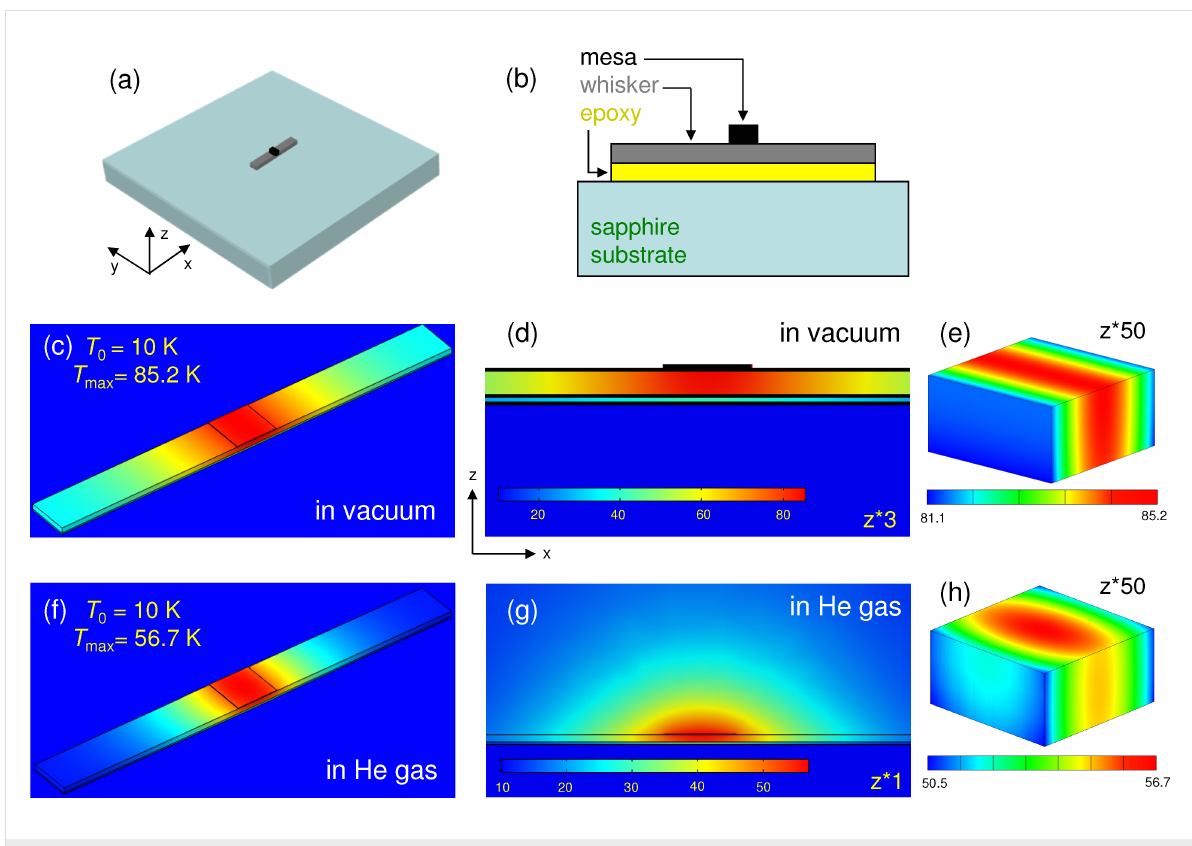
Figure 3: Heat transport in a whisker-based device without electrodes. (a) A sketch of the device and (b) a cross section through the mesa (not to scale). (c–e) Calculated temperature distribution for the device in vacuum. (f–h) The same for the device in exchange He gas.